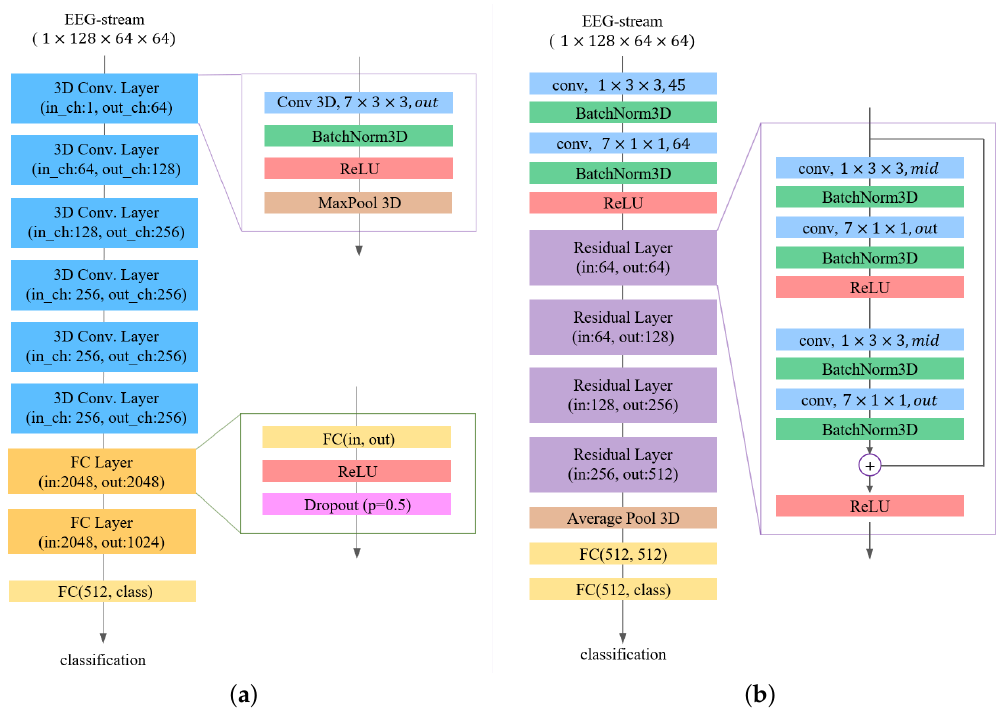
Figure 6. The proposed 3D CNN models. ( a ) C3D model; ( b ) R(2 + 1)D